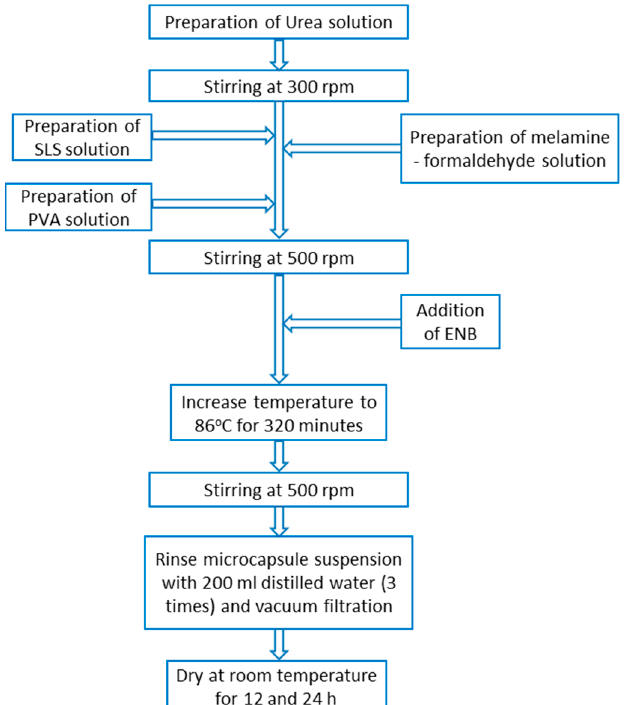
Figure 9. Schematic illustration of melamine-urea-formaldehyde microcapsule synthesis with embedded 5-ethylidene-2-norbornene as repair agent.